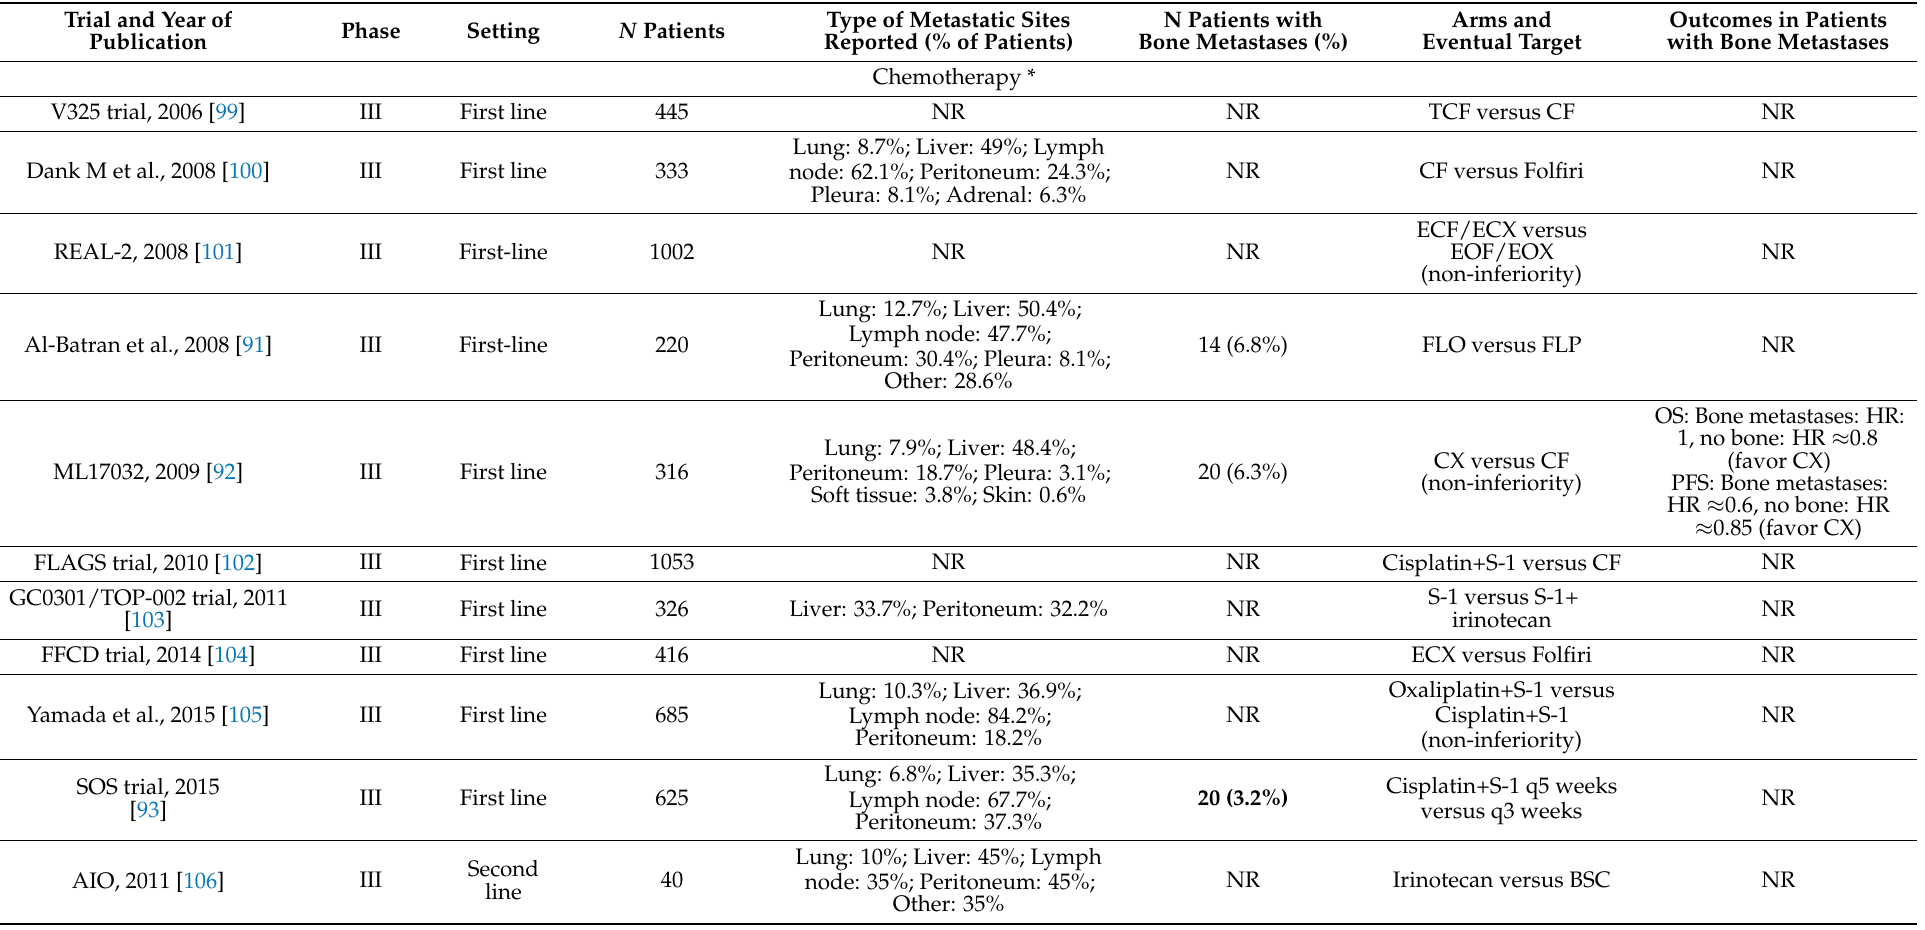
Table 2. Data regarding bone metastases according to the landmark phase II/III trials in metastatic gastric